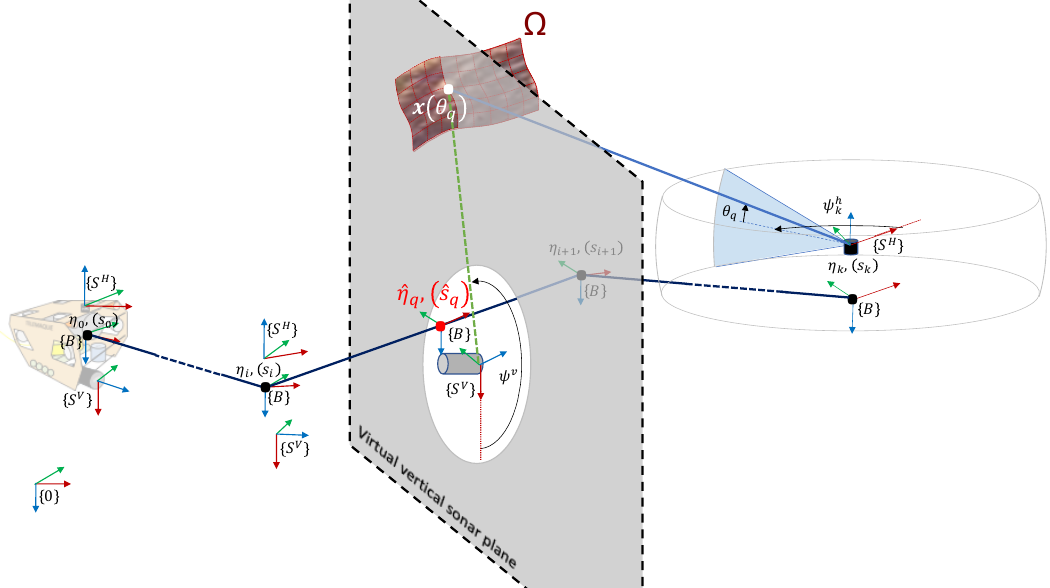
Figure 7. Elevation angle estimation illustration where the vertical sonar plane is parallel to the ZY plane of the